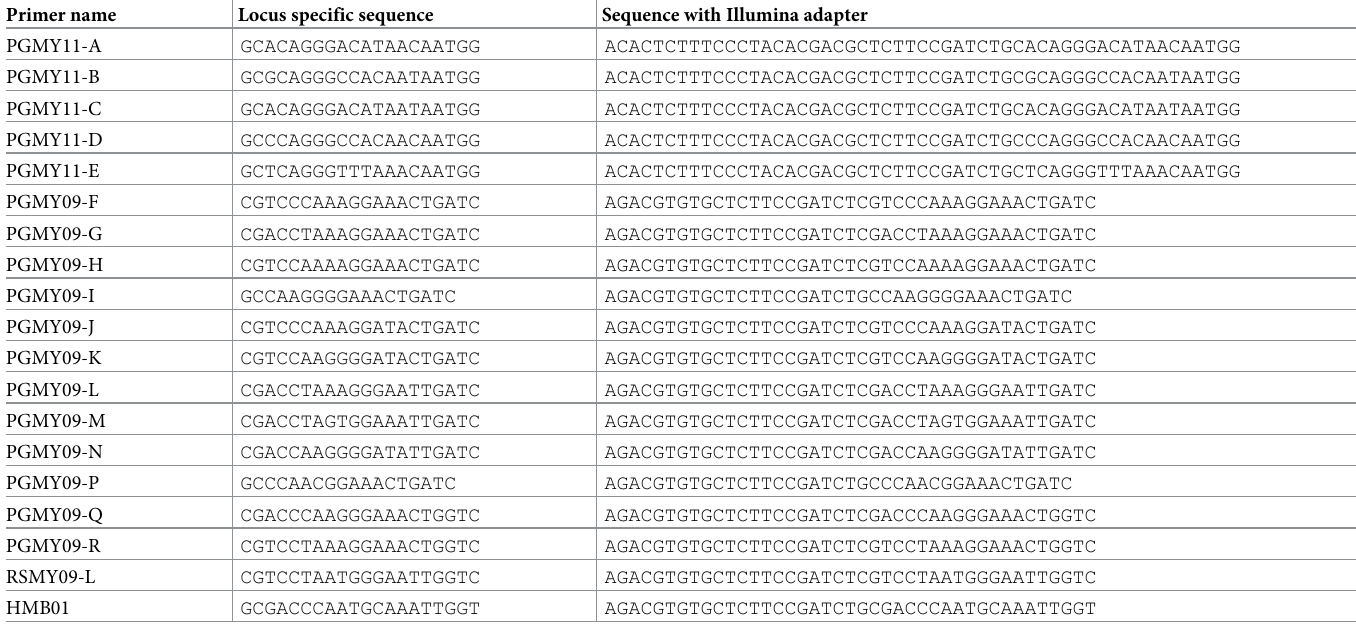
Table 1. List of PGMY primers used for Illumina